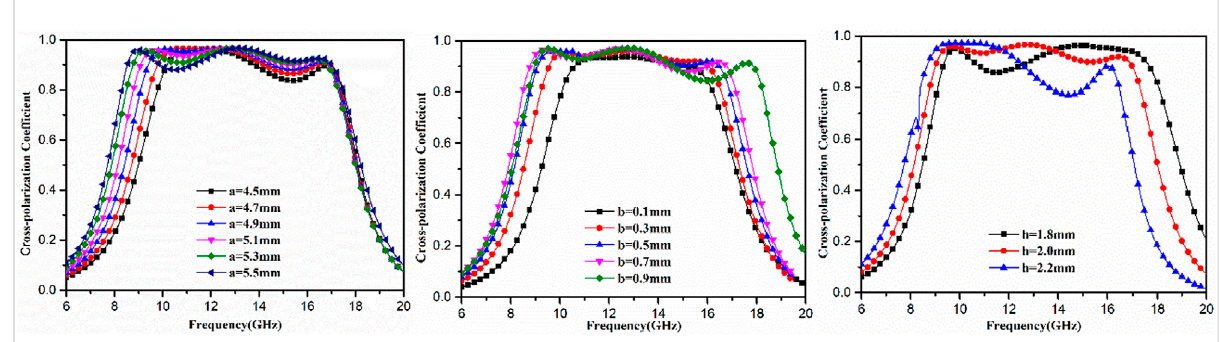
FIGURE 7 Simulated results of the cross-polarization re fl ections show that the length, width, and thickness of cut wires vary with frequency.